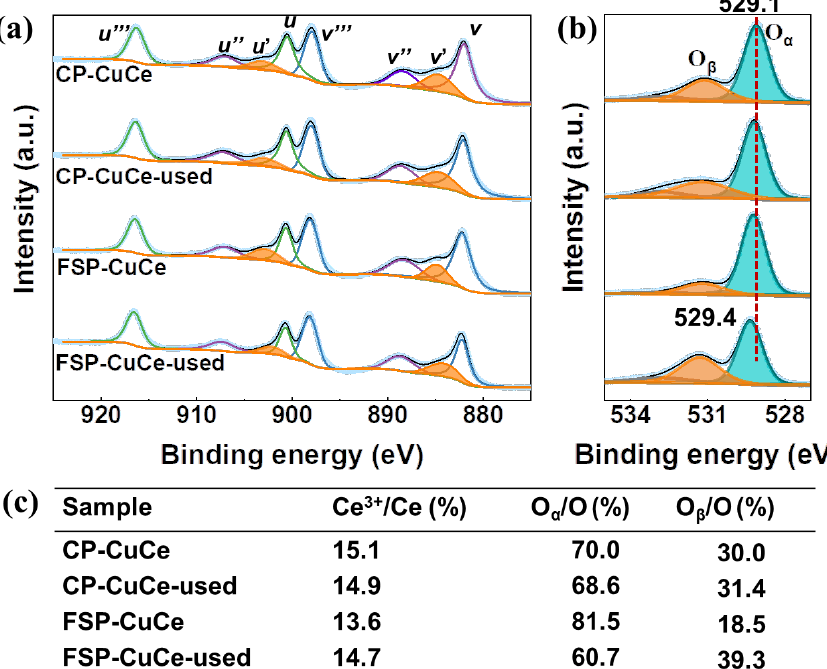
Figure 9. XPS spectra of ( a ) Ce 3 d and ( b ) O 1 s over FSP-CuCe and CP-CuCe, as well as their used samples. ( c ) Summary of surface compositions of Ce 3+ and different oxygen species derived from XPS spectra.